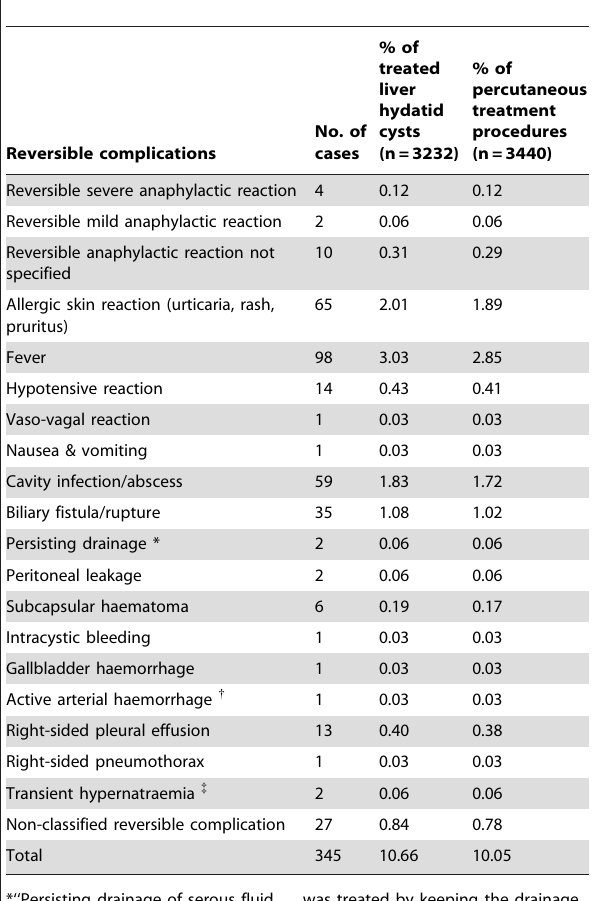
Table 3. Reversible complications due to percutaneous treatment of hydatid liver cysts.